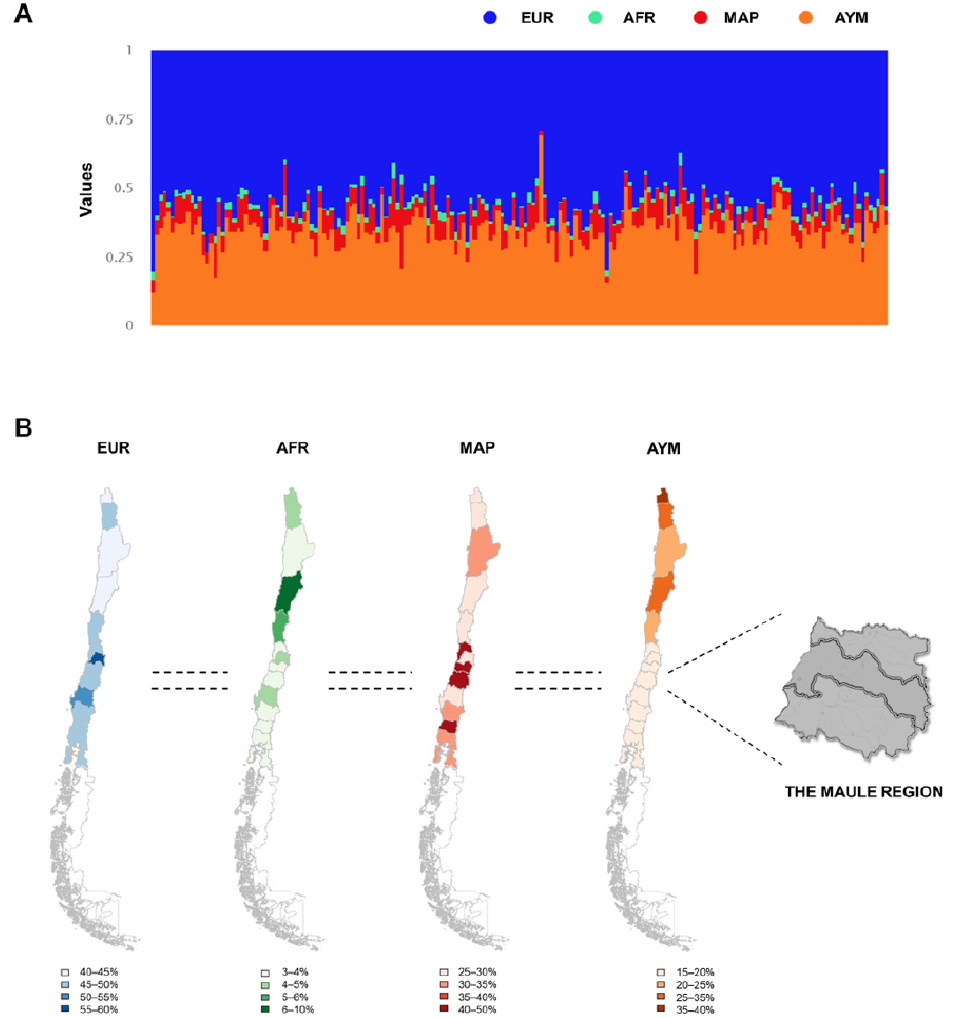
Figure 1. Analysis of Population Structure. ( A ) Estimation of the ancestry proportions of the 190 individuals in this study; ( B ) Maps with average regional African, European, Aymara and Mapuche proportions in Chile.